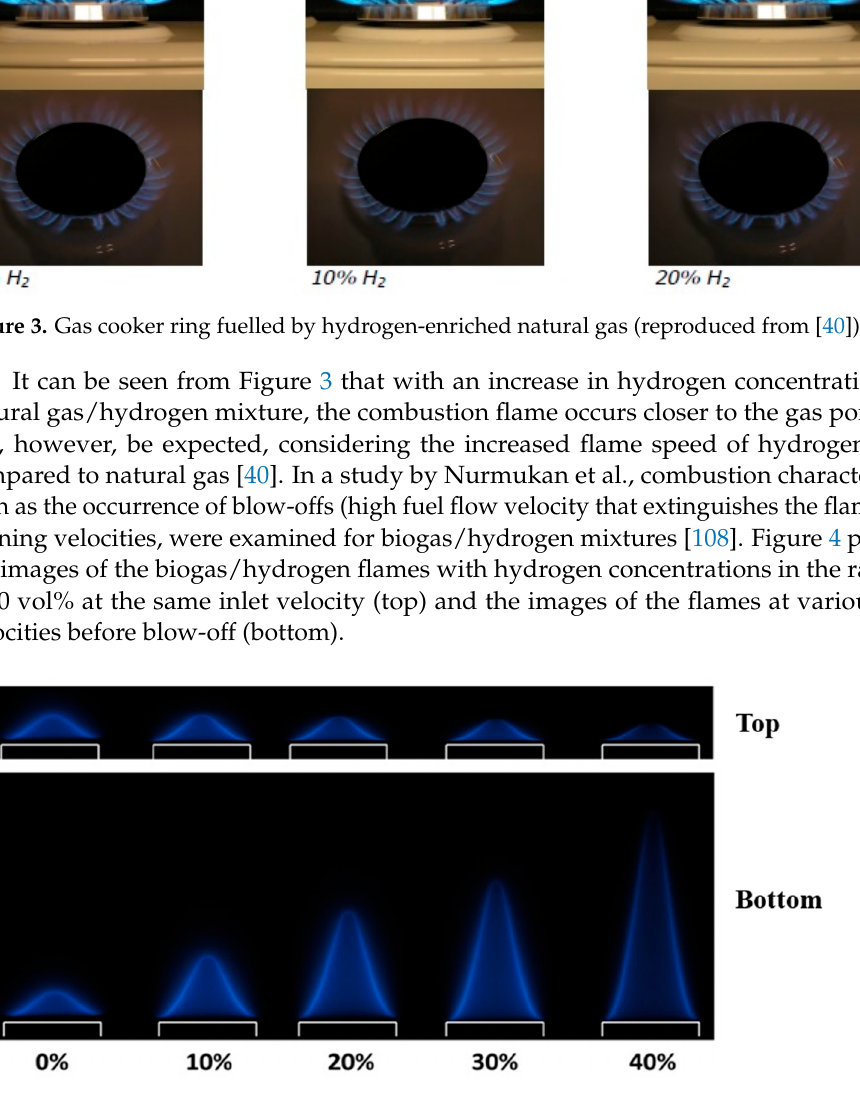
Figure 4. Photographs of premixed flames with hydrogen additions (0–40 vol%) ( top ) at the same inlet velocity and the flames at various inlet velocities before blow-off ( bottom ) (adapted from [108] with permission from John Wiley and Sons).